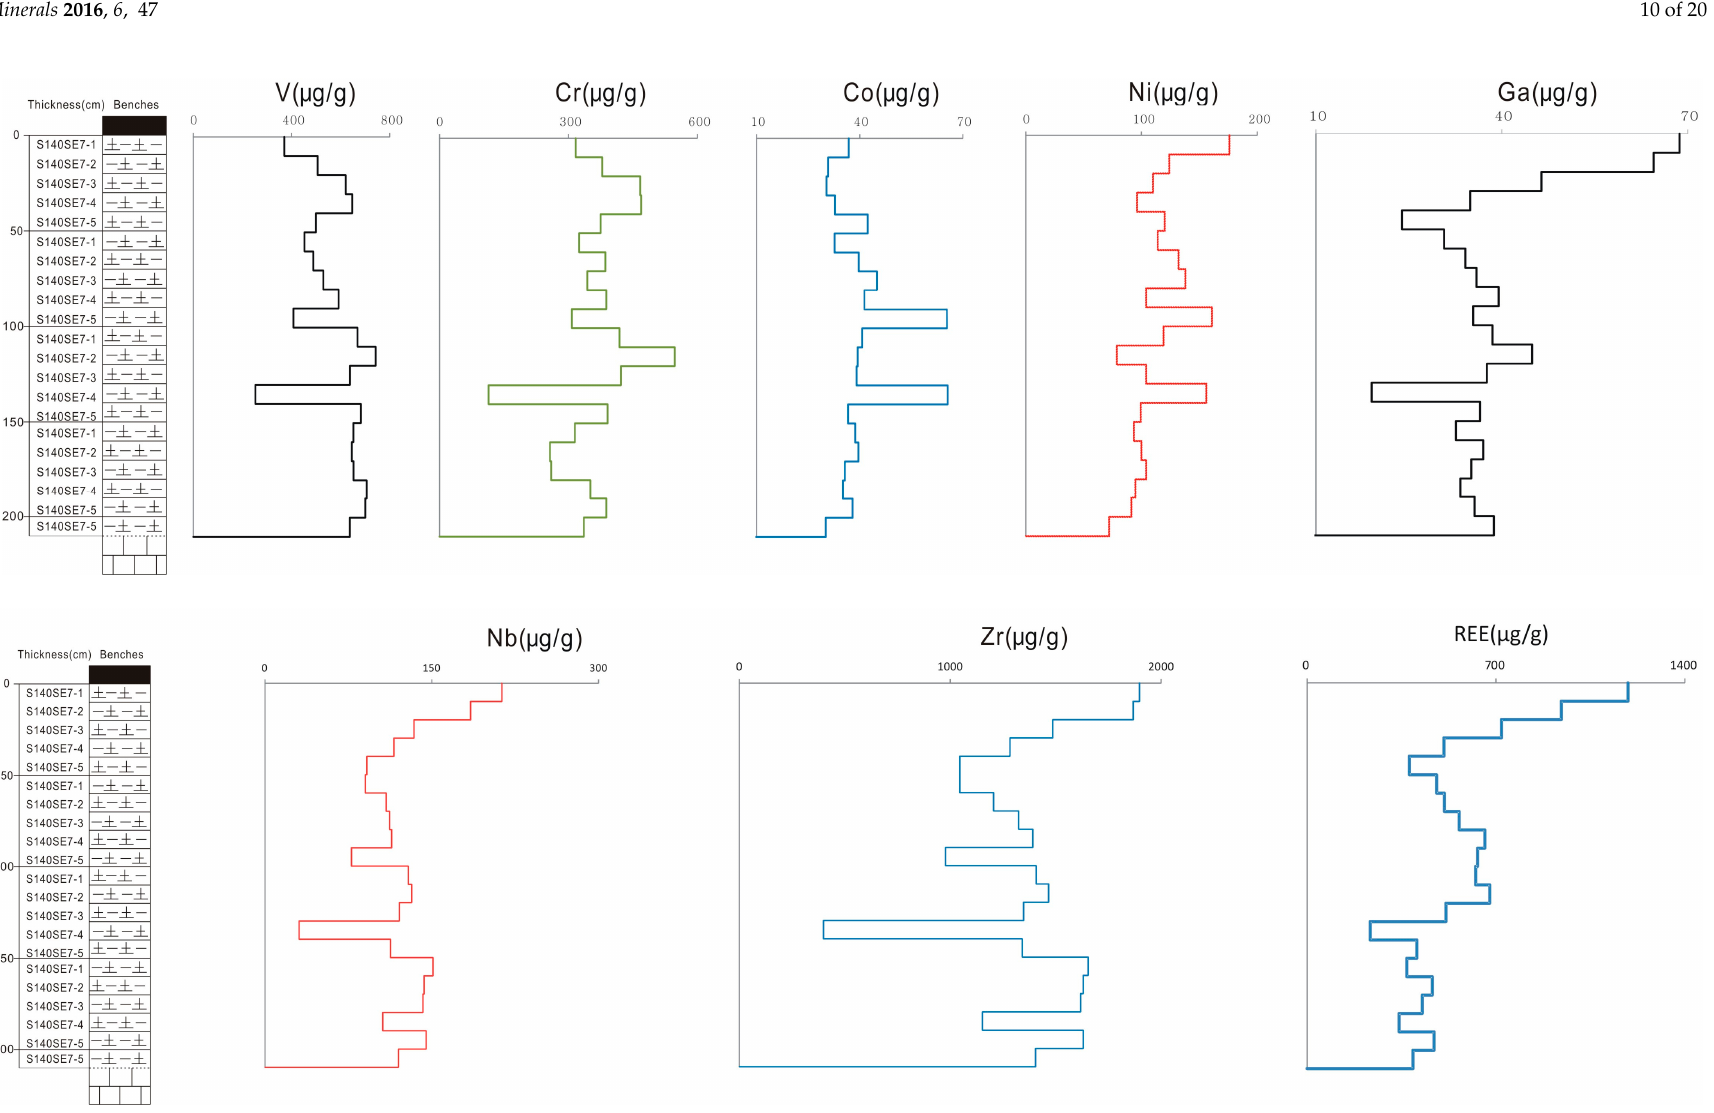
Figure 6. Vertical variations of selected trace elements of the tuff in Zhongliangshan mine, Chongqing.